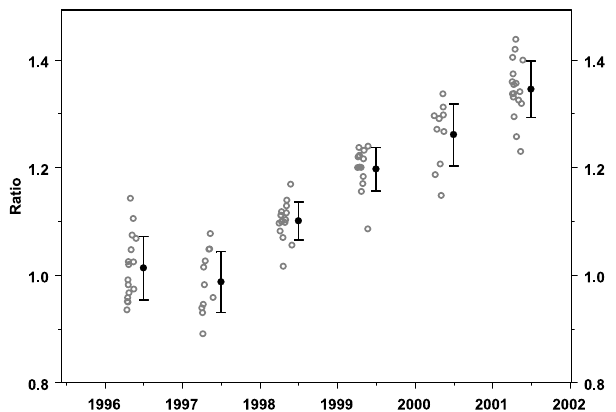
Figure 3. The calibration constants for the prototype of the Solar Light instrument in the period 1996–2001 derived from a compari- son of the modeled clear-sky doses, assuming fixed aerosol optical depth (0.16 at 340nm) with the observed ones in cloudless condi- tions in the March–June period. Full circles and bars represent the mean value and ± 1 standard deviation range in the selected year.